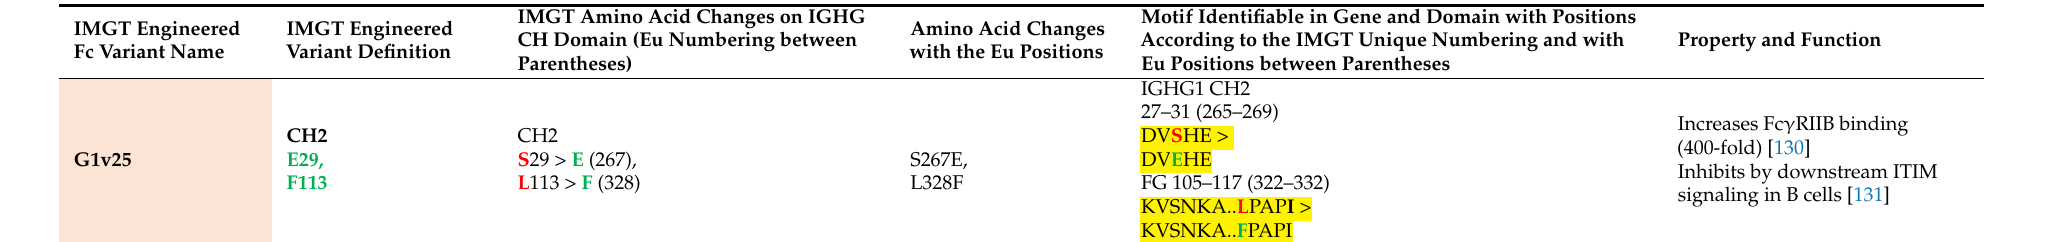
Table 11. IMGT nomenclature, Eu positions and IMGT motif of engineered Fc variants involved in the B cell inhibition by the coengagement of antigen and Fc γ R on the same cell (Effector #7].